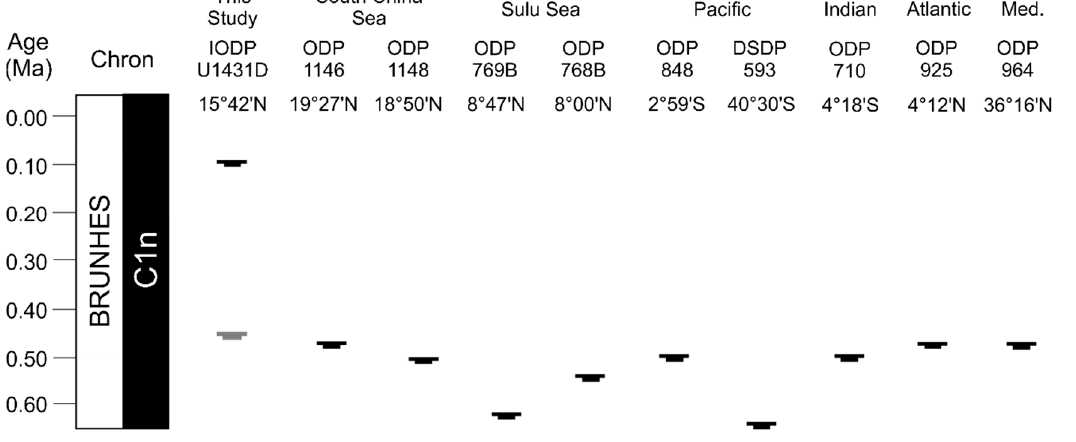
Figure 10. Comparison of stratigraphic ranges of LO of Pseudoemiliania lacunosa from IODP/ODP/DSDP Sites. Magnetostratigraphic records from IODP Site U1431D, ODP Sites 1148, 769B, 768B, 848, 710 and DSDP Site 593 are calibrated to the astronomically tuned Geomagnetic Polarity Time Scale (GPTS) of [61] as compiled by [9]. Oxygen isotope data is used to determine the ages in ODP Sites 1146, 925 and 964. These datums are calibrated to the benthic foraminiferal δ 18 O time scale of [2]. Horizontal bars represent the recalculated datum ages for each site. Black datum in IODP Site U1431D represents age acquired from magnetostratigraphy. Gray datum in IODP Site U1431D represents placement of the datum from this study using the datum age reported in [9]. Med.— Mediterranean.